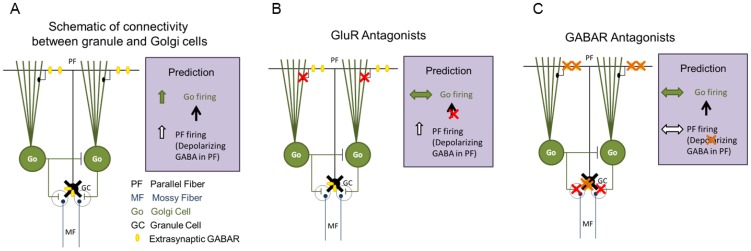
Schematic of the circuit hypothesis for ethanol-enhancement of synaptic GABA release from Golgi neurons.
A. Schematic of the connectivity between cerebellar granule cells and Golgi cells including the inhibitory connections between Golgi cells identified in recent studies [33]. Location of extrasynaptic GABARs in granule cell somata and parallel fiber axons is illustrated. Prediction (right panel), illustrates the proposed changes in neuronal activity in the circuit following increased activation of parallel fiber GABARs. B. Hypothesized effect of GluR antagonists on circuit activity following increase in activation of granule cell extrasynaptic GABARs. Red X indicates blocked glutamatergic synapses. C. Predicted effects of GABAR antagonists on granule and Golgi cell activity following increased activation of granule cell extrasynaptic GABARs. Red X indicates blocked GABA synapses and orange X denotes block of both somato-dendritic and axonal extrasynaptic GABARs.